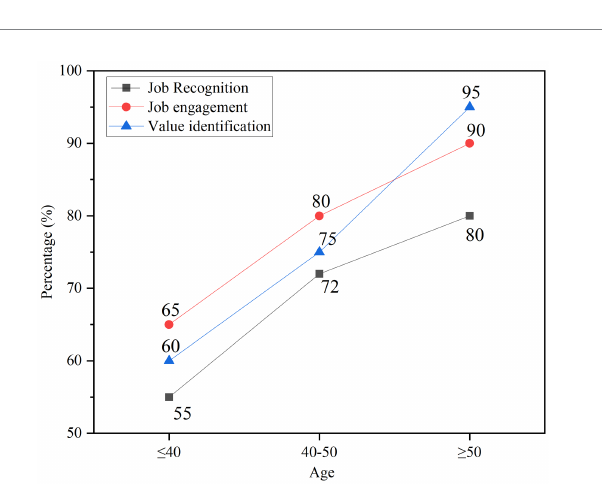
FIGURE 10 The influence of psychological emotions on teachers’ work